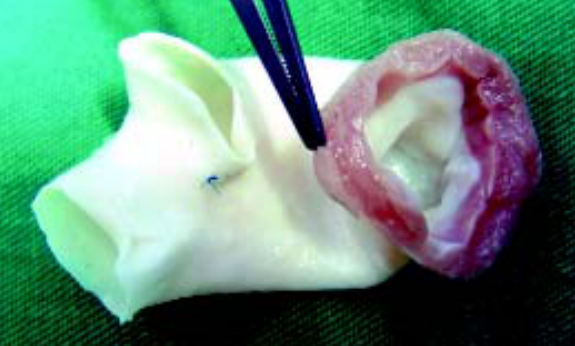
Fig. 3 – Homoenxerto decelularizado. Notam-se paredes mais finas e delicadas habitualmente encontradas nos homoenxertos criopreservados